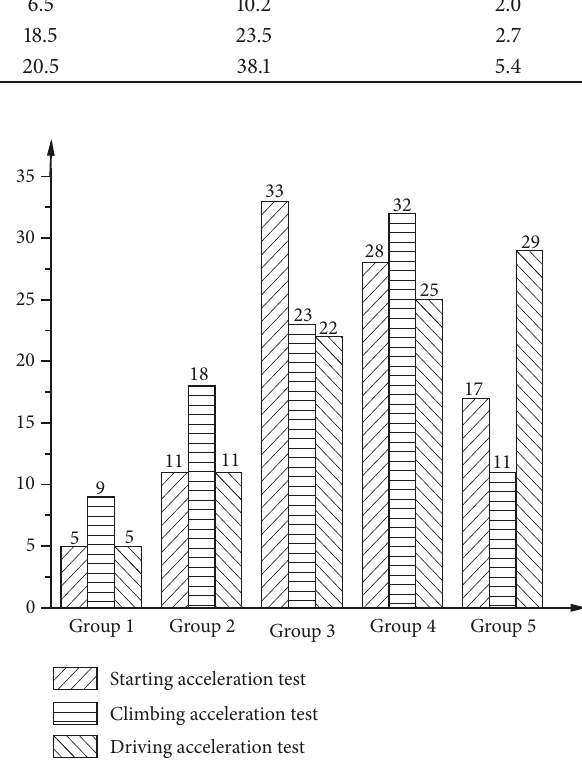
Figure 4: Accelerationtime results of the three different